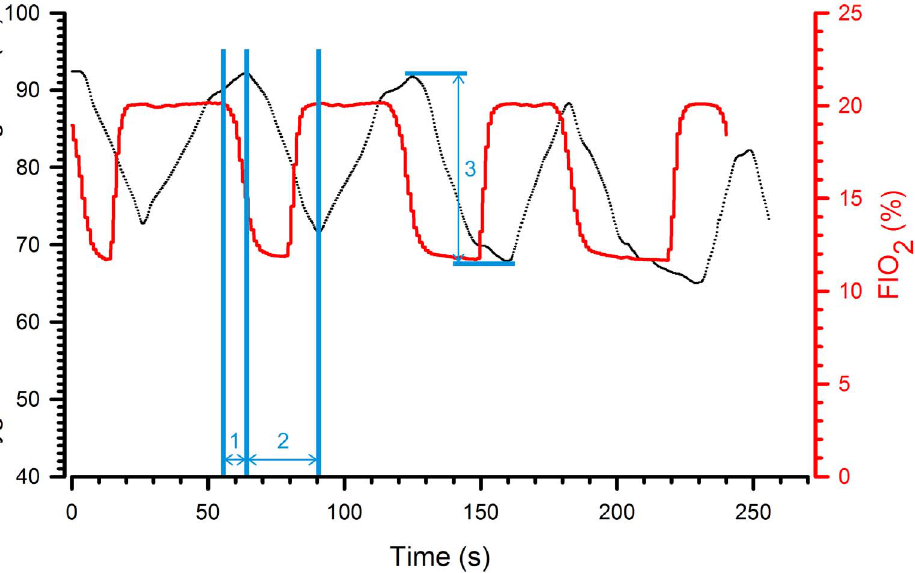
Figure 4. Evolution of haemoglobin oxygen saturation in response to a cyclic change in FIO 2 . Traces from a representative animal. Saturation was assessed during four consecutive cycles of 60 s during which the hypoxic phase was progressively lengthened (15, 20, 30 and 40 s). The red line corresponds to FIO 2 in the inspired air, the black line to the transcutaneous measurement of haemoglobin oxygen saturation of the animal. Latency (1); time to peak (2) and amplitude of change in saturation (3).